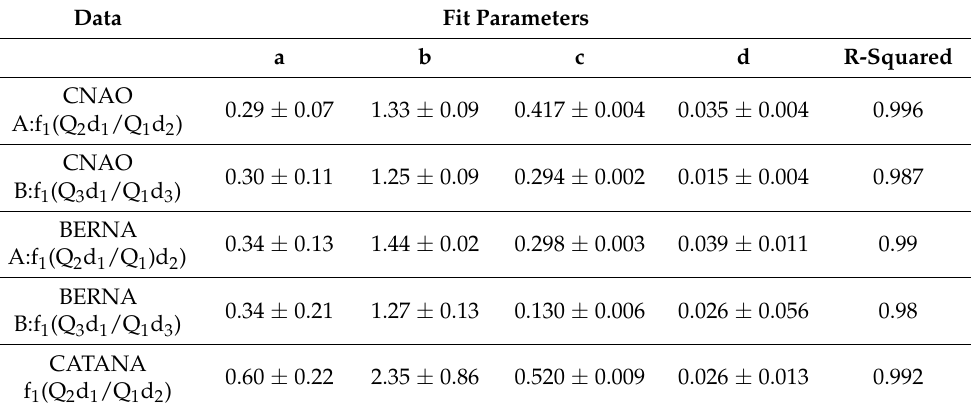
Figure 6. Calibration curves measured for chamber 1 as a function of Q (cid:2924)(cid:4593) d 1 / Q (cid:2869)(cid:4593) d n . The fit A describes Table 2. Parameters of the calibration curves achieved through the fits to the CNAO, Bern and the results achieved using data from chamber 1 and chamber 2, while fit B describes the data from CATANA chamber 1 and chamber 3. The color indicates the beam intensity.